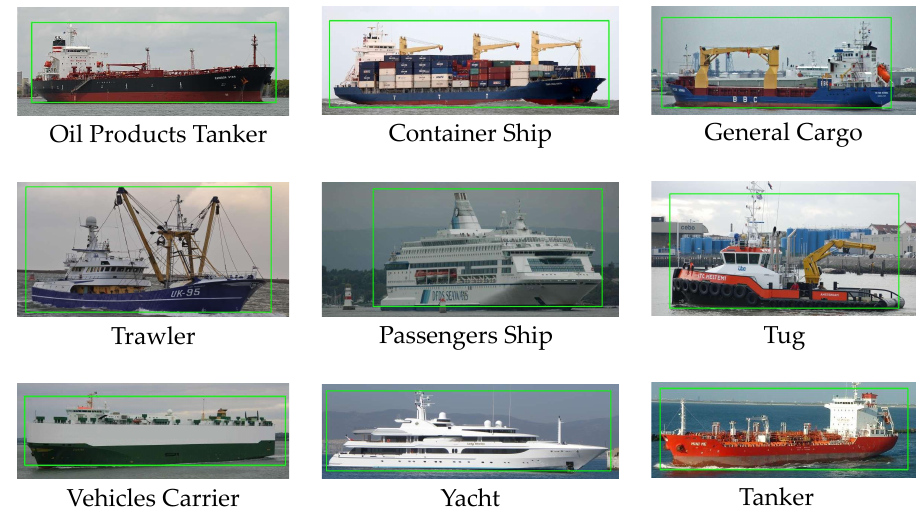
Figure 5. Examples of classes in MARVEL